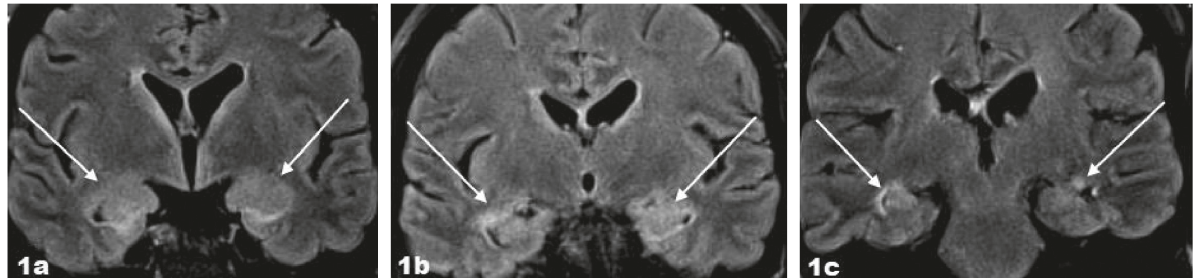
Figure 1: (a–c) Coronal FLAIR-MRI scan reveals slight enlargement and increased signal intensity of the amygdala and hippocampus bilaterally. Table 1: All autoantibodies tested in serum and spinal fluid in our patient (all were below reference values). Onconeuronal and encephalitis autoantibodies in spinal fluid Onconeuronal and encephalitis autoantibodies in serum Antinuclear antibodies and antineutrophil cytoplasmic antibodies in